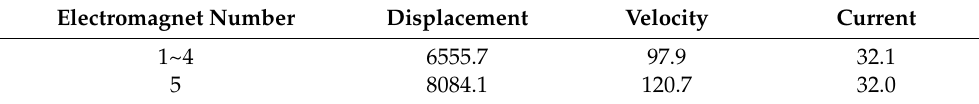
Table 1. Feedback Table 1. Feedback gain.